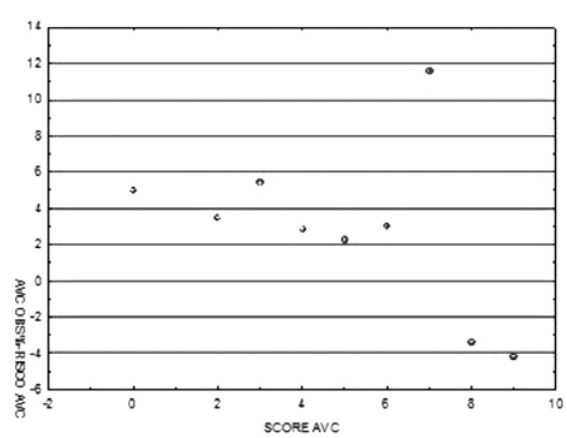
Fig. 3 - Comportamento médio da porcentagem de AVC observada e estimada segundo escore da NNECDSG